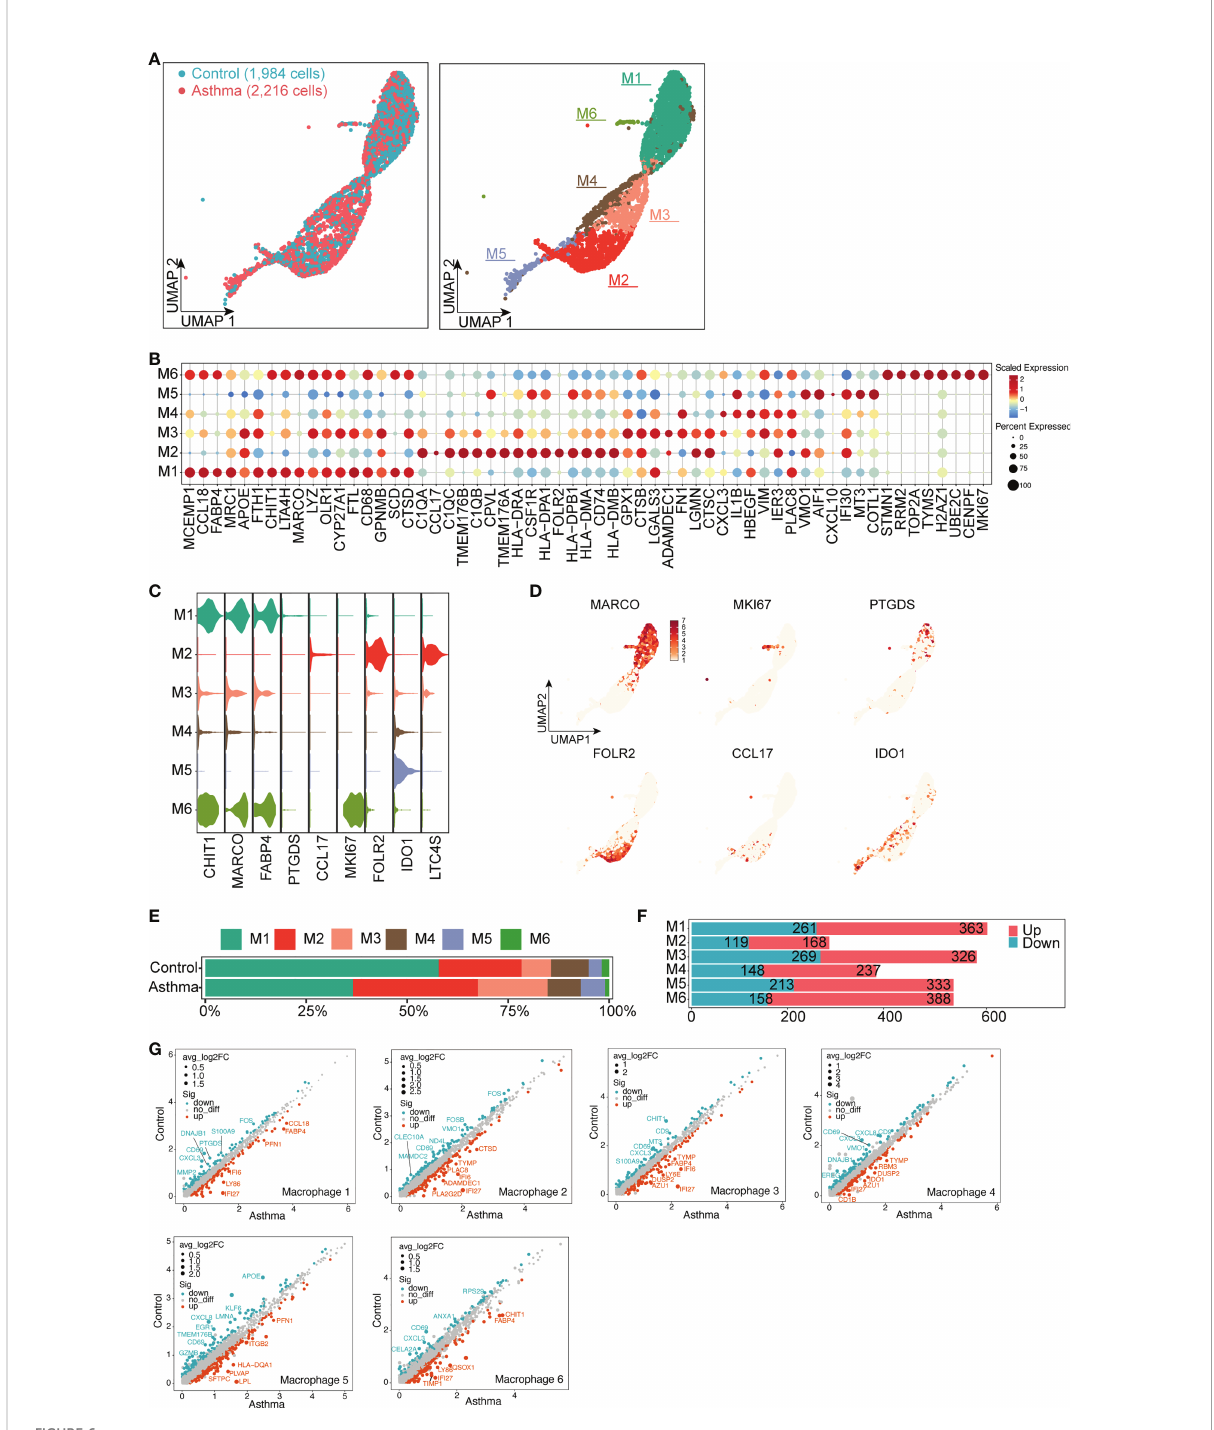
FIGURE 6 Typical differential genes expression signatures in 6 subtypes of macrophage cells in A.suum -induced asthma. (A) , UMAP visualization of the macrophages in the control and asthma groups identi fi ed 6 subsets. Captured cells: control = 1,984, asthma = 2,216. Each point represents a single cell, colored according to the sub-cluster assigned. (B) , Dot plot showing the top ten marker genes in each sub-cluster. Blue and red indicate lower and higher expression, respectively. (C) , Violin plots showing the signature gene expression (CHIT1, MARCO, FABP4, PTGDS, CCL17, MKI6, FOLR2, IDO1 and LTC4S) in different macrophage subsets. (D) , UMAP visualization of unique gene expression speci fi cally distinguishes each cluster. (E – F) Representation of the cell numbers proportion and DEG numbers of the control and asthma in each subtype. (G) , Scatter plots showing a pairwise comparison of gene expression between the control and asthma groups. DEGs are highlighted and representative DEGs are labeled. The size of dots is proportional to the fold change of gene